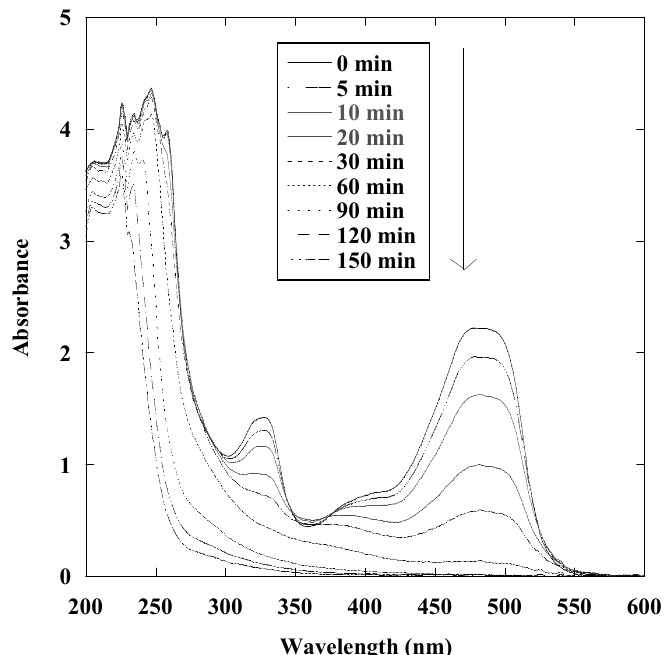
Figure 14. AO10 degradation UV–Visible absorption spectra ([AO10] 0 = 50 mg/L, 20 ± 1 °C, [IO 4 − ] = 3 mM, irradiation intensity: 15 mW/cm²).